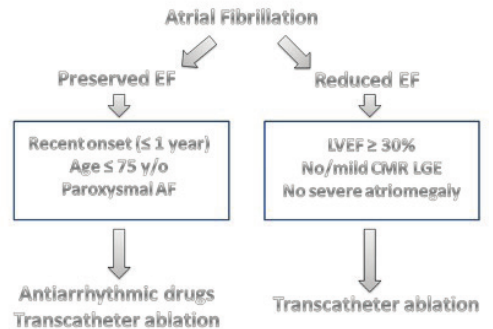
Figure 1 - Algorithm for AF rhythm control in the transcatheter ablation